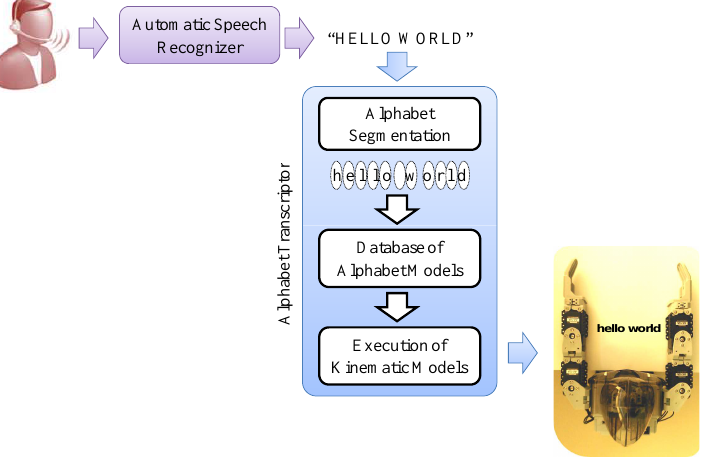
Figure 2. Modules of the speech-to-text transcriptor.